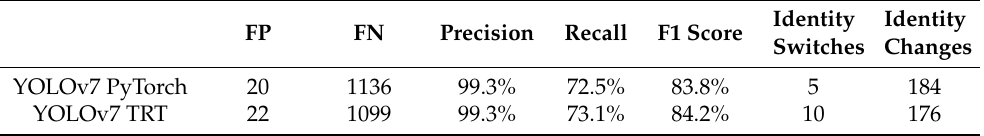
Table 6. Number of false positive detections (FPs), false negative detections (FNs), precision, recall, F1 score, identity switches, and identity changes for the PyTorch and TRT implementation of the YOLOv7 object detection model on test video 4 (resolution of 1920 × 1080, length of 4 mn and 25 s, FPS of 24) captured by a drone, showing a single class of ’cars’. FP